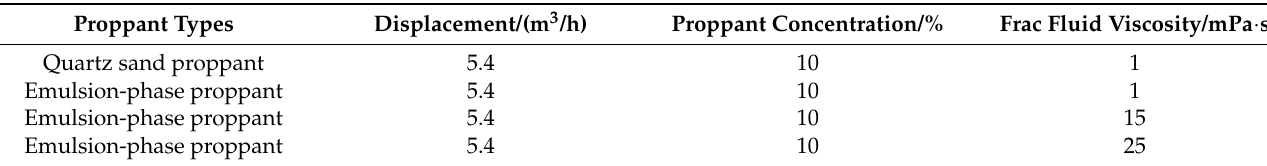
Figure 14. Visual proppant migration test device. Table 4. Proppant migration and sedimentation test